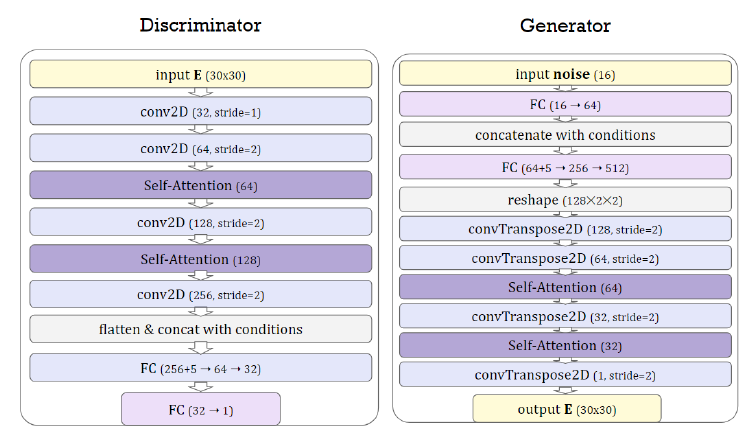
Figure 2: SAGAN architecture.